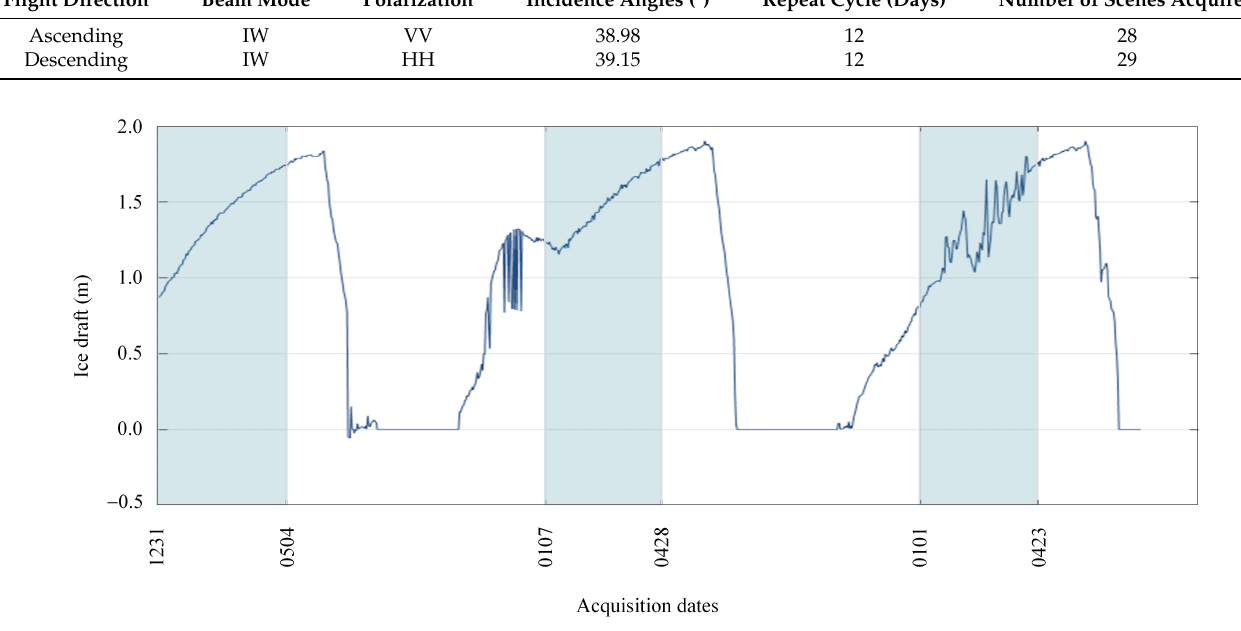
Figure 4. Ice draft changes from an ice profiler near Cambridge Bay. The part with a light-blue background is the period that covers the acquisition dates of the SAR images used in this